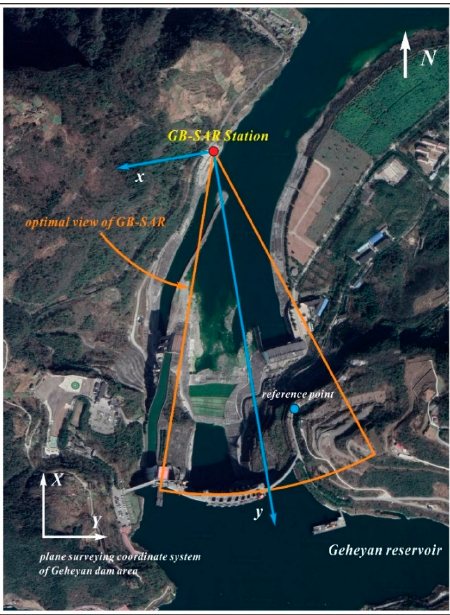
Figure 4. Ground-based synthetic aperture radar (GB-SAR) monitoring range in dam area.